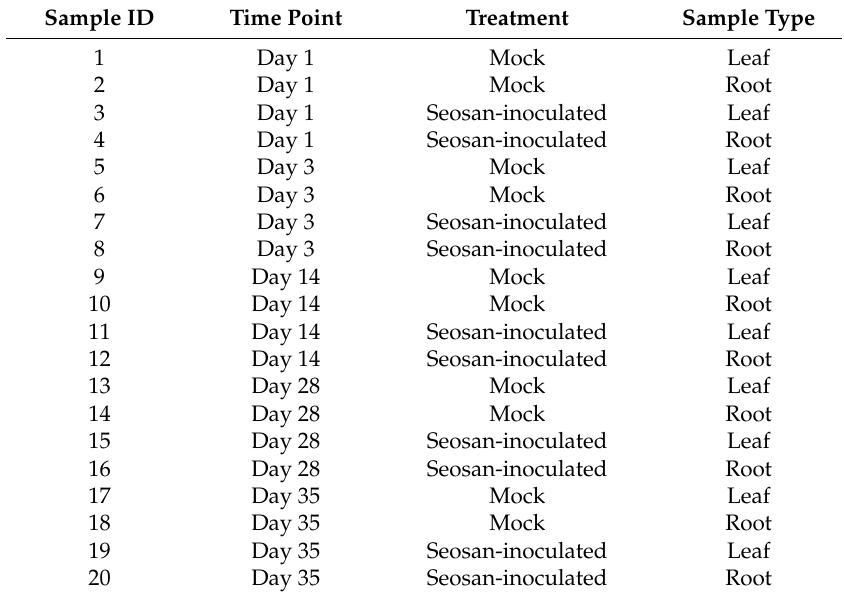
Table 3. Leaf and root samples collected from Seosan-inoculated and mock-treated plants at five di ff erent time points under two di ff erent